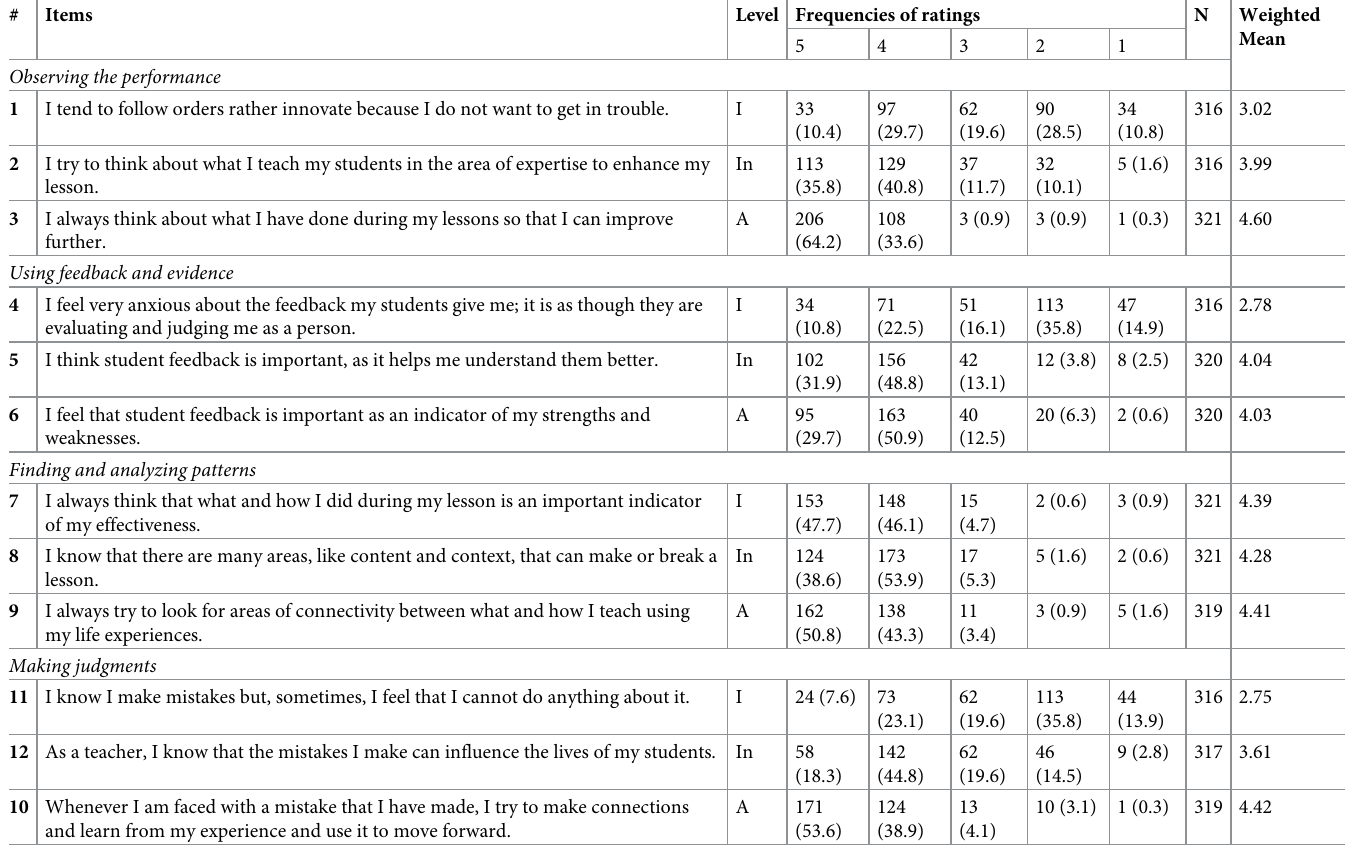
Table 1. Descriptive statistics for mathematics teachers’ ability to